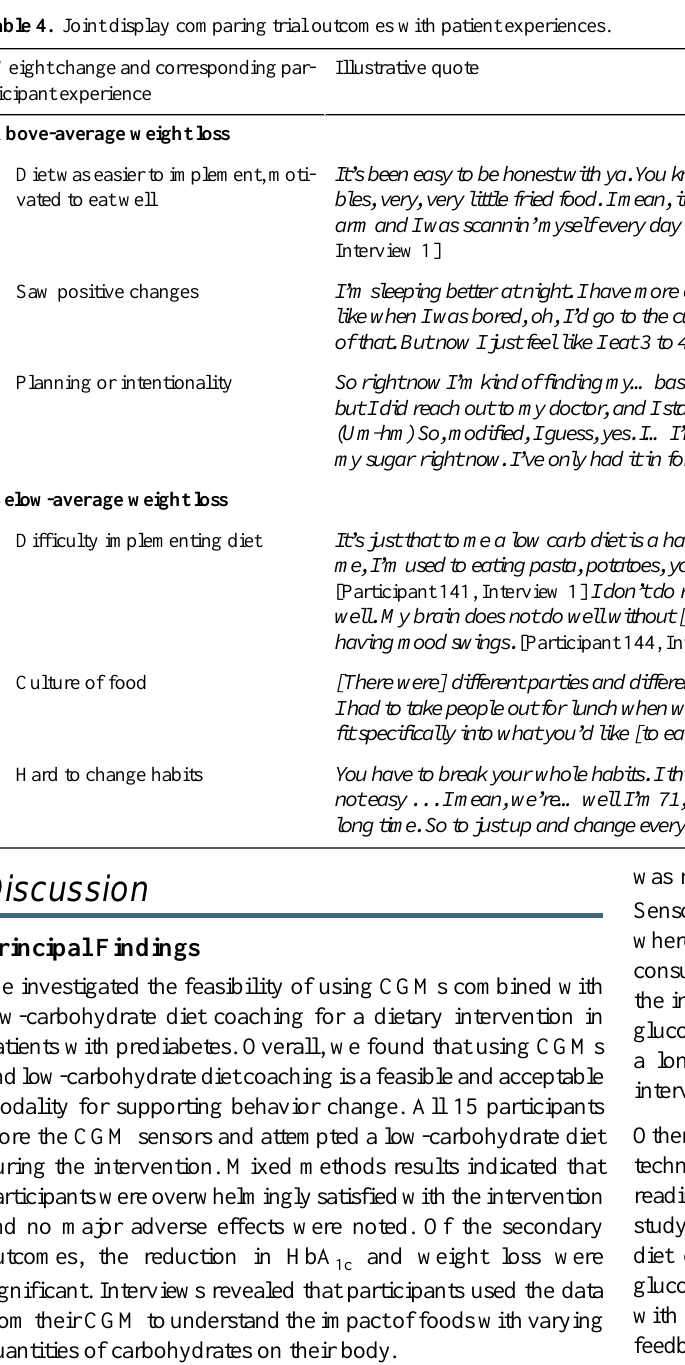
Table 4. Joint display comparing trial outcomes with patient experiences. ticipant